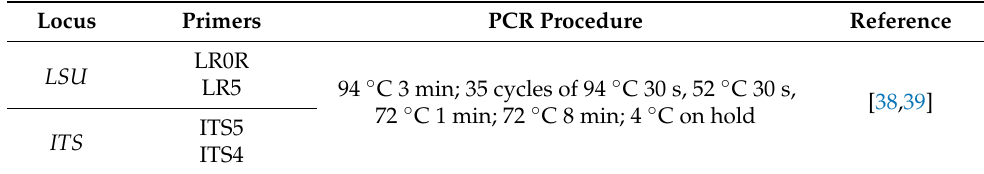
Table 1. Primers and PCR protocol used in this study.